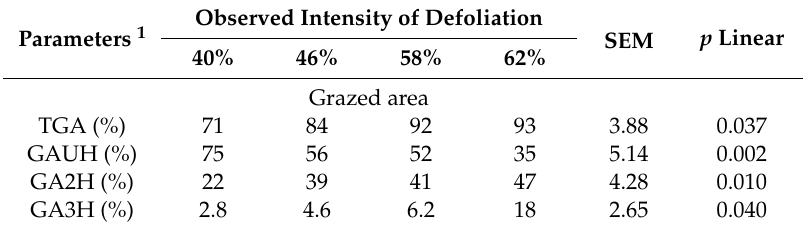
Table 3. Grazed area in kikuyugrass pastures subjected to di ff erent intensities of